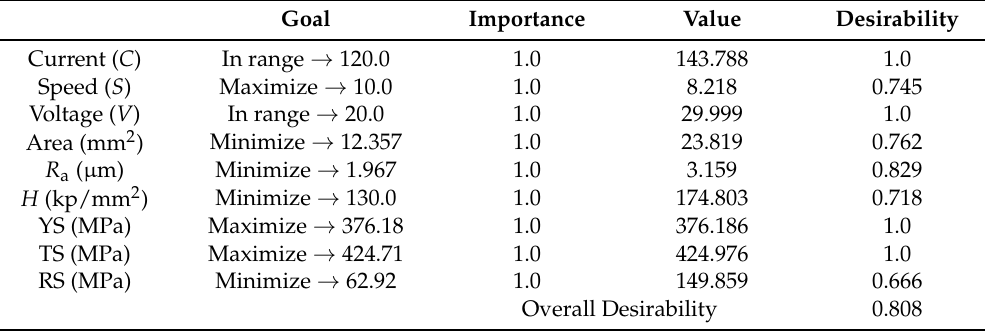
Table 10. The first criterion considered: all variables considered equally important.